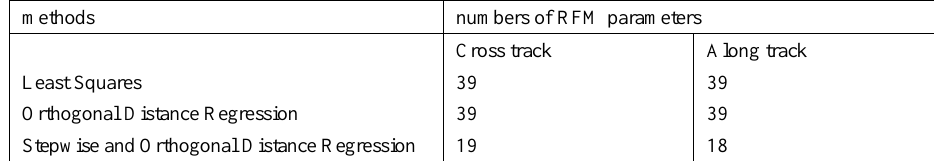
Table 1. Numbers of RFM parameters of different